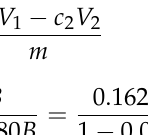
Figure 1. Examples of CMC powders from ( a ) pine wood, ( b ) bamboo, ( c ) pine needles, ( d ) bamboo leaves, and ( e ) hemp hurd.